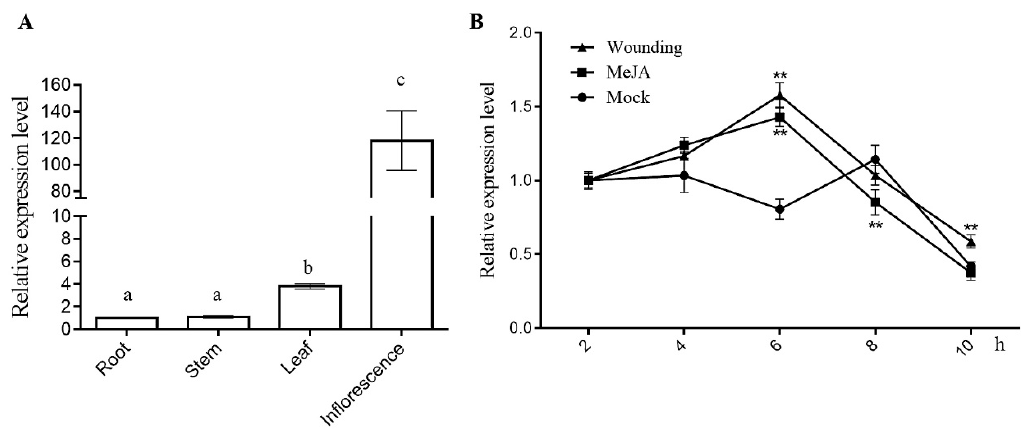
Figure 3. Transcription analysis of AaCOI in different tissues ( A ) and in response to wounding and MeJA treatment ( B ). The error bar represents the mean (±standard error) of three independent biological replicates. Columns marked with different letters ( a – c ) are significantly different from the others (ANOVA followed by Tukey’s multiple comparison test ( p < 0.05)); any points of the line chart marked with an asterisk are significantly different (Student’s t -test; ** p < 0.01). Error bars indicate SD.